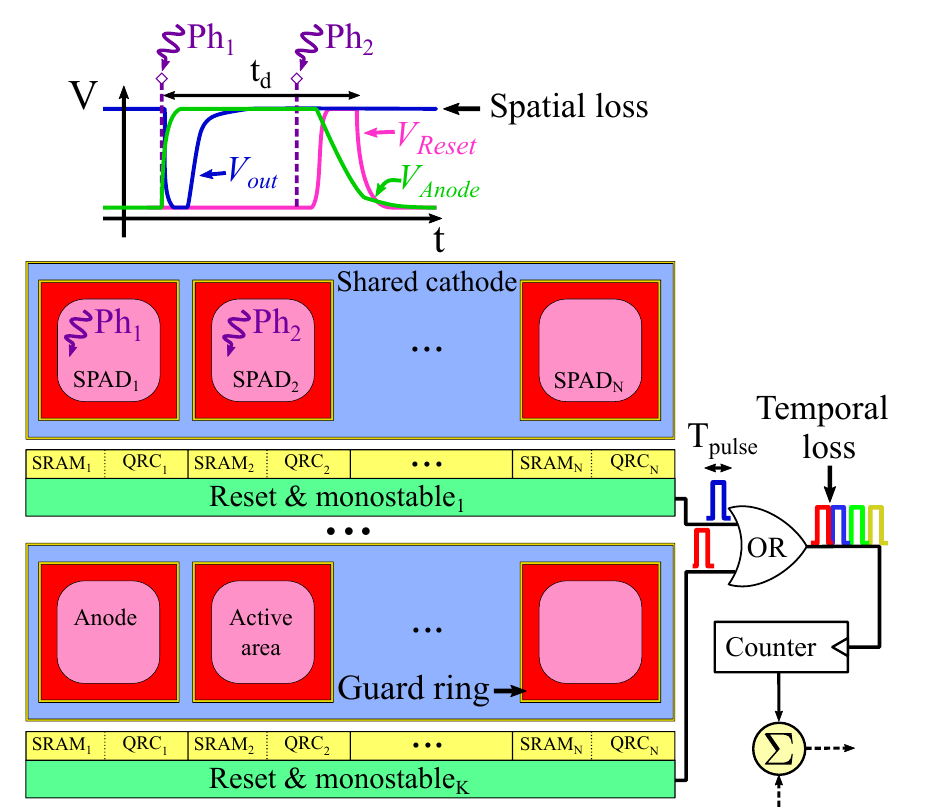
Figure 5. Simplified diagram of a subpixel with K microcells connected to a counter through an OR-bus. Each microcell is composed of N µ c SPADs with their QRCs and SRAMs, a shared reset circuit, and a shared